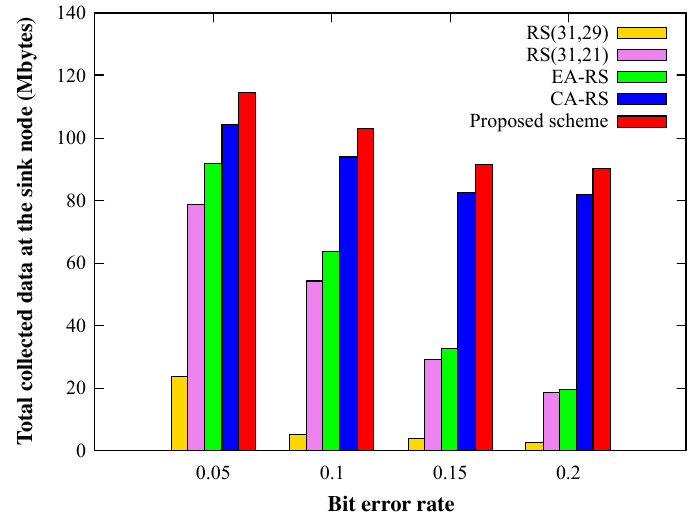
Figure 15. Received data of sink for varying BER (node